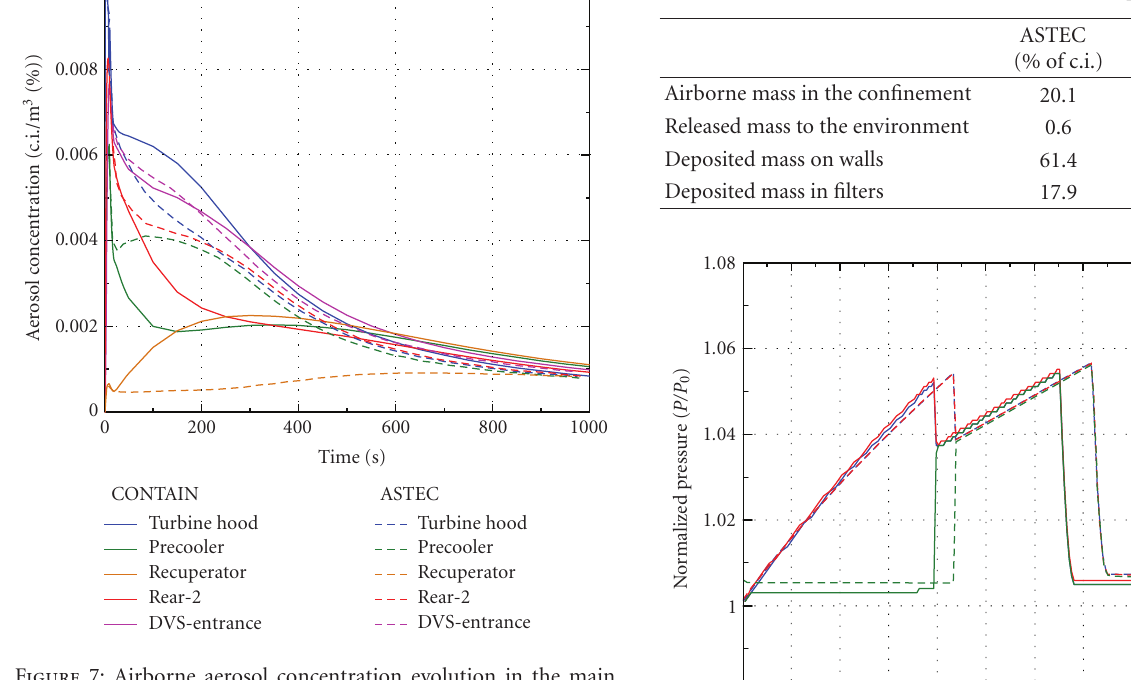
Figure 7: Airborne aerosol concentration evolution in the main confinement compartments for the LB sequence (long term sim- ulation).